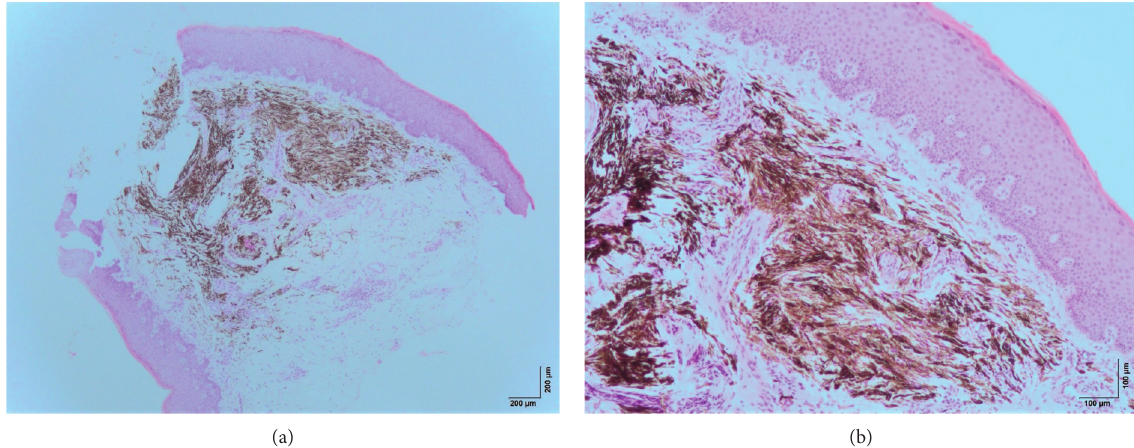
Figure 2: Microscopic examination at magnifications 40x (a) and 100x (b) with hematoxylin and eosin. There is a noncircumscribed submucosal proliferation of elongated spindle-shaped melanocytes that are grouped in short fascicles some of them arranged parallel to the overlying epithelium. The melanocytes contain a variable amount of melanin pigments in the cytoplasm. Some fibrosis is observed in between the fascicles of pigmented cells. There is no atypia or areas of necrosis. No mitoses were observed.